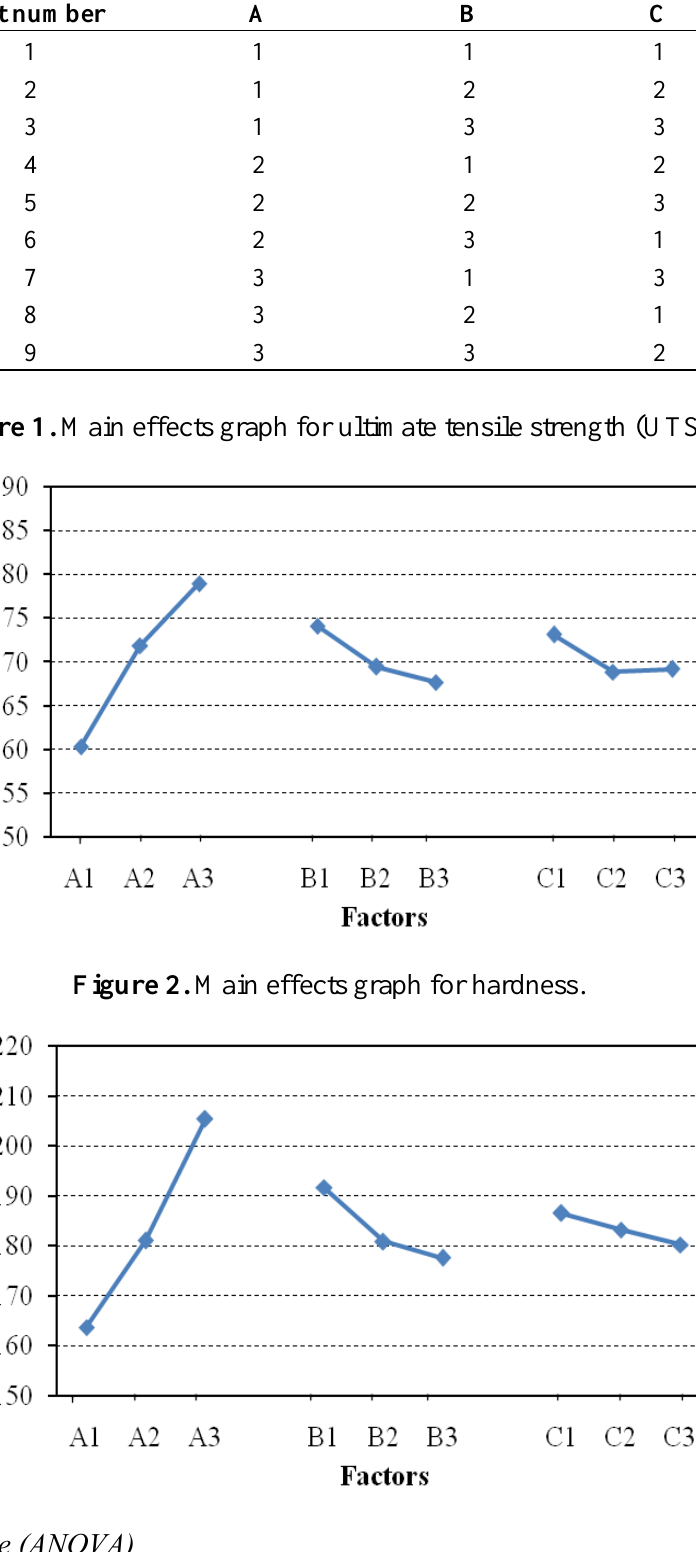
standard orthogonal array. 9